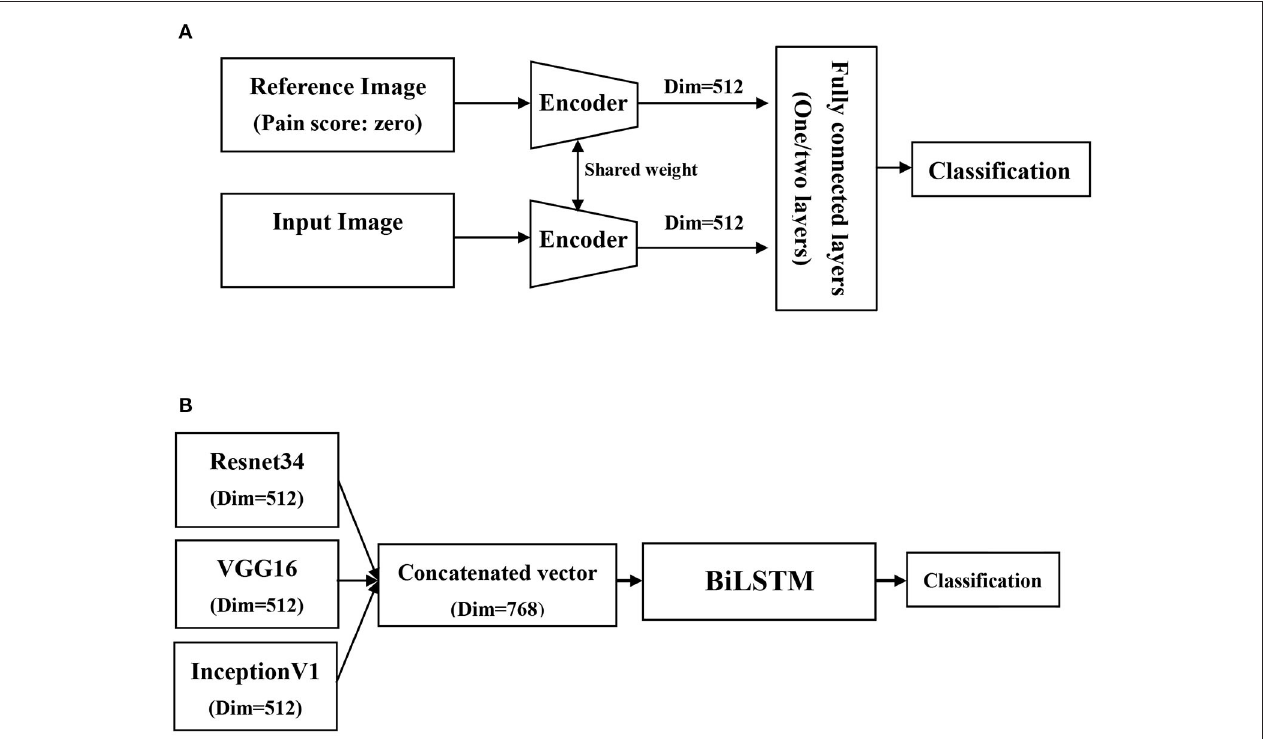
FIGURE 2 | Schematic diagram of network architectures in the present study. (A) Image-based pain classifiers using relation and siamese network architecture, (B) Video-base pain classifier using bidirectional long short-term memory networks